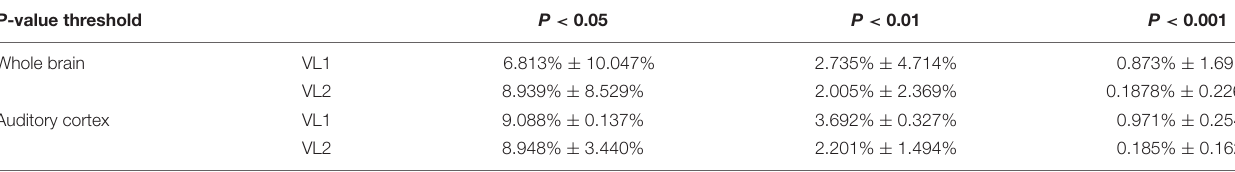
TABLE 1 | Summary findings of P -value by type I error percentage for whole brain and auditory cortex. P -value threshold P < 0.05 P <